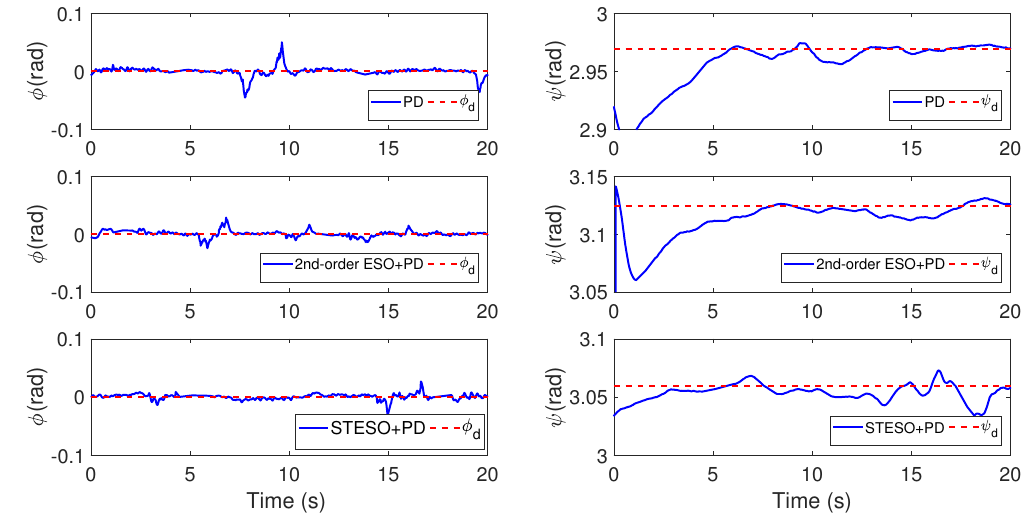
Figure 10. Experimental curves of φ and ψ with different DUE in Case A.